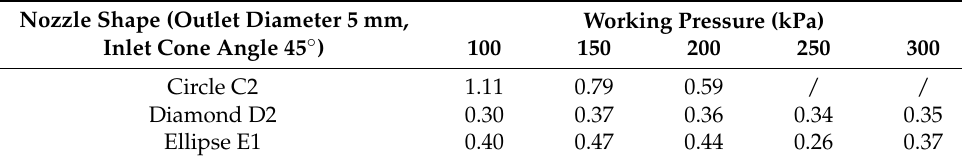
Table 3. Coefficient of variation for nozzles with different shapes under different working pressure levels.